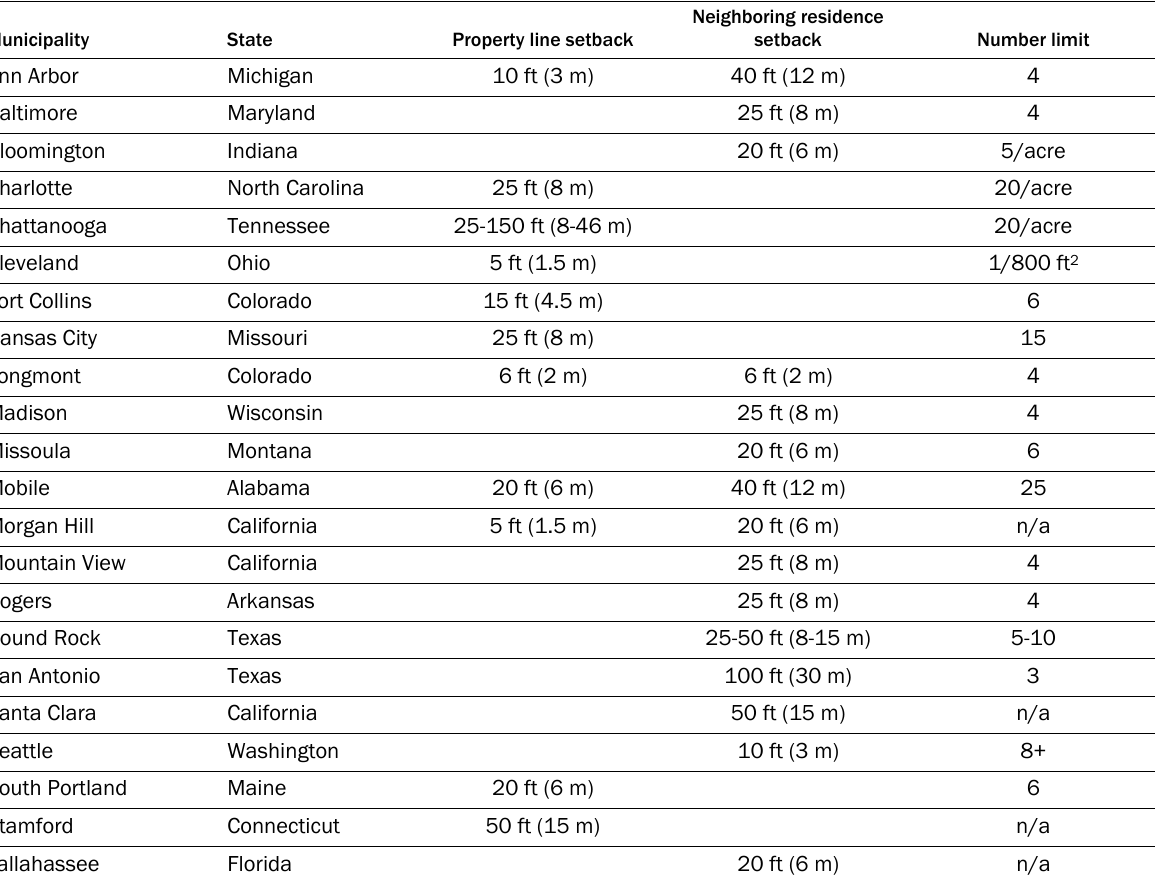
Table 3. Site-Level Restrictions (Chickens